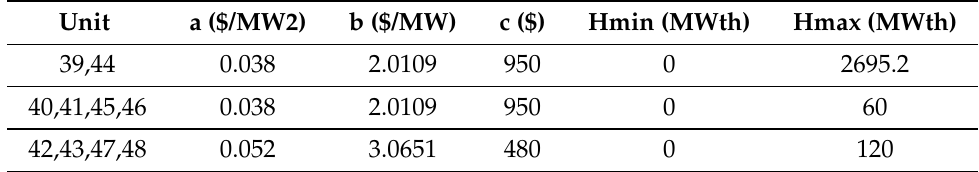
Table A18. Heat energy generator unit data for Case Study